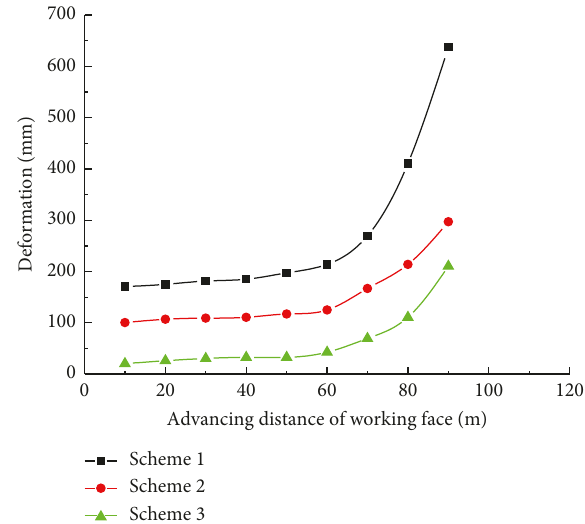
Figure 9: Relative deformation between the roof and floor of assistant retracement channel.